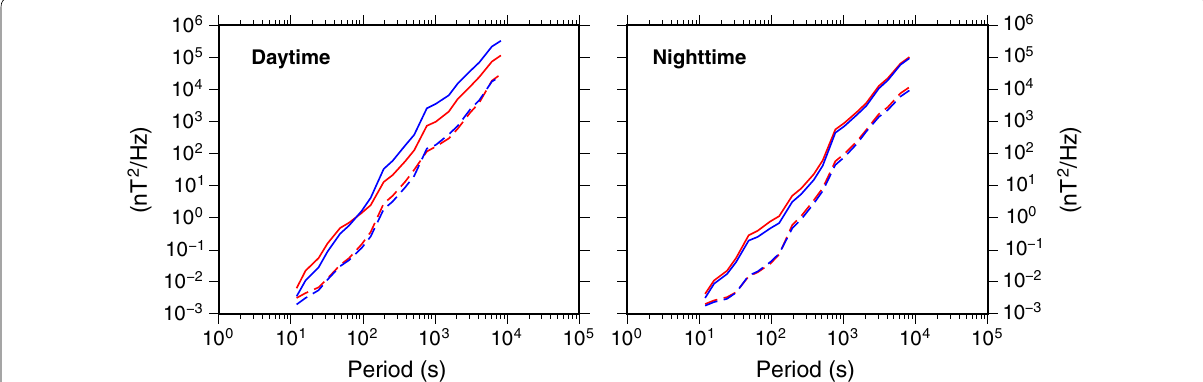
Fig. 6 Comparison of the power spectra of the horizontal components of the magnetic field at two stations during the 1994 experiment. Red lines for CB station, blue lines for PRM station. Continuous lines are H-component; dashed lines are